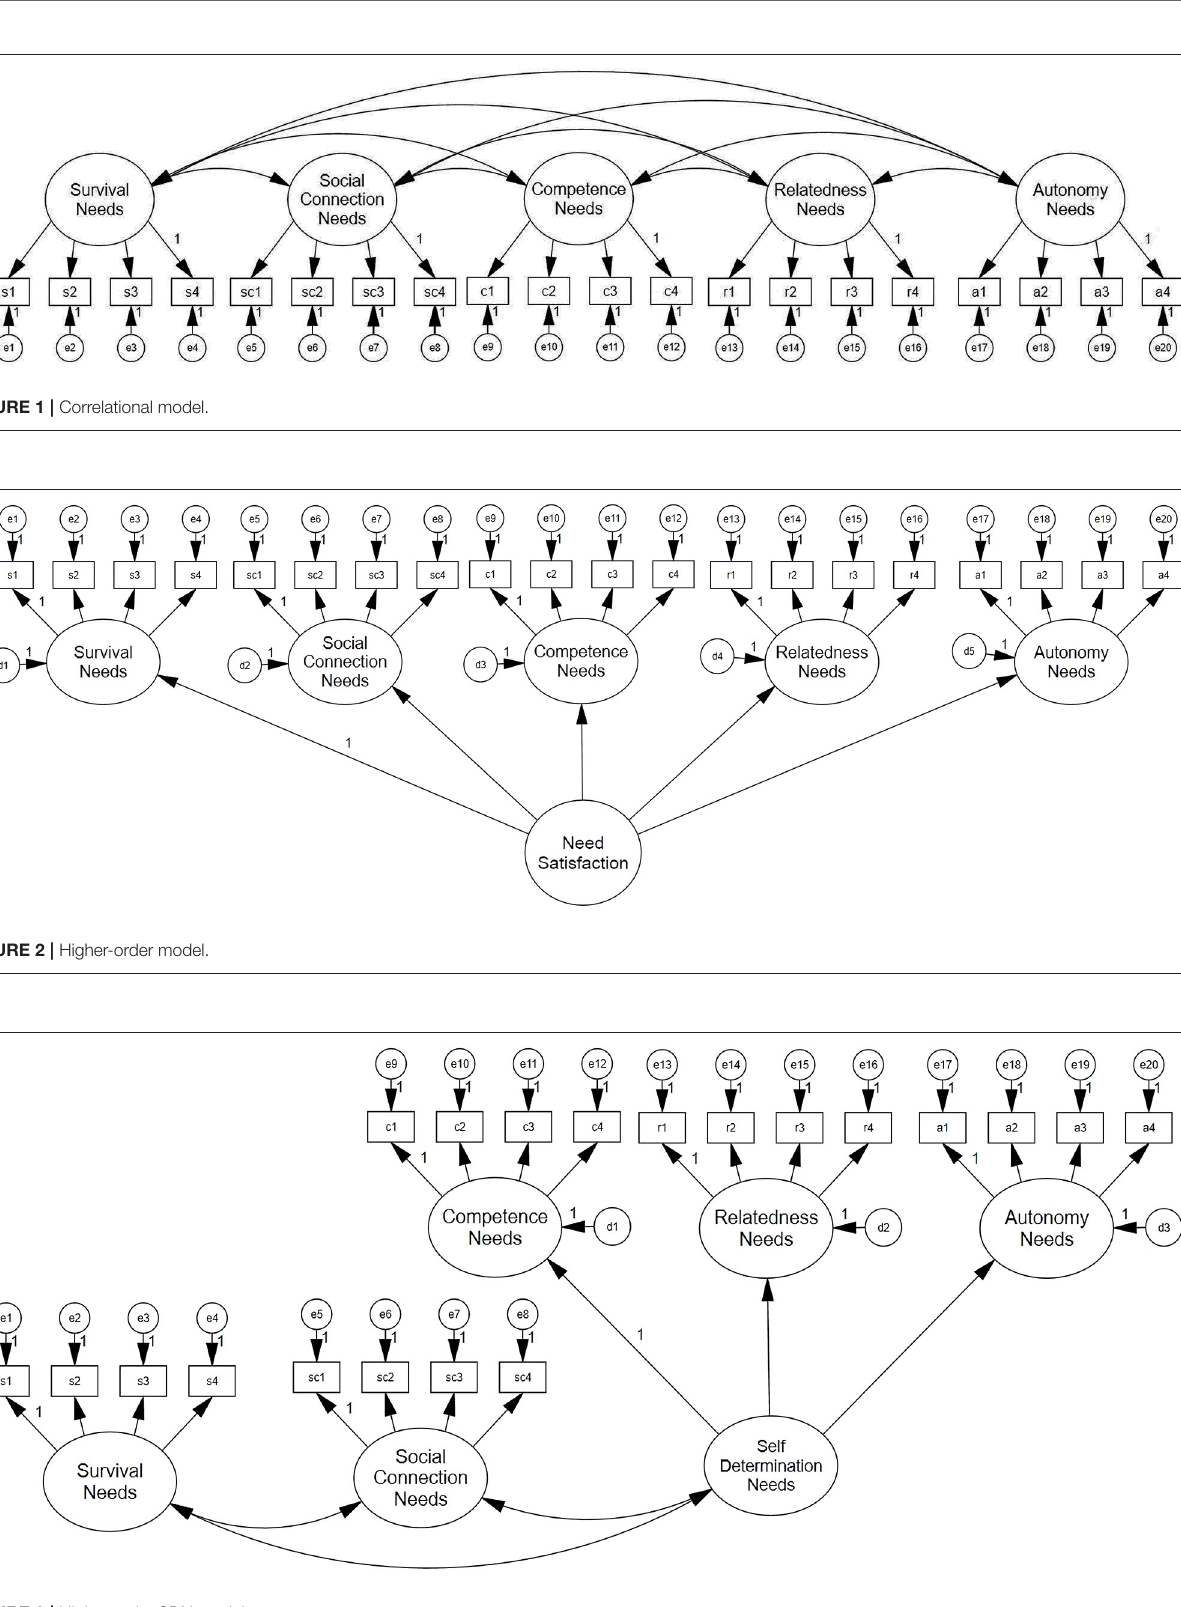
FIGURE 3 | Higher-order SDN